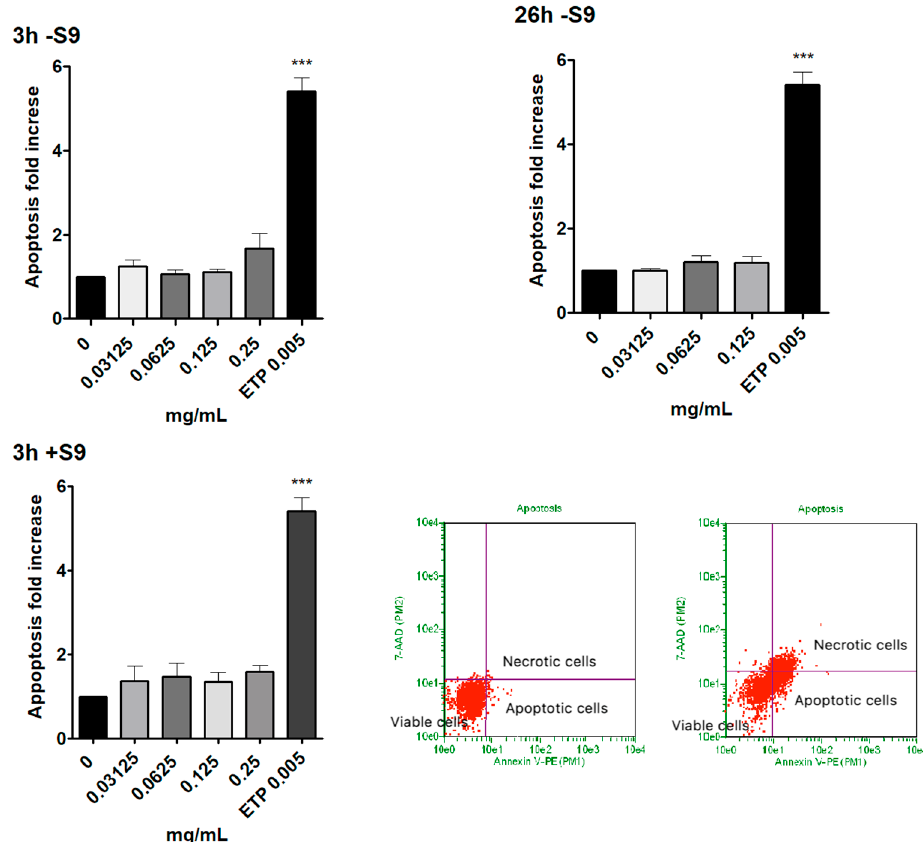
Figure 2. Apoptosis fold increase on TK6 cells after 3 h − S9 mix, 26 h − S9 mix and 3 h +S9 mix treatment with the SMD or ETP at the indicated concentrations compared to the concurrent negative control (0 mg/mL). Each bar represents the mean ± SEM of at least three independent experiments. Data were analysed using repeated ANOVA, followed by Dunnet post-test. *** p < 0.001 vs. (0 mg/mL). Lower right: representative FCM dot plots of viable, apoptotic and necrotic cells after 26 h − S9 mix in culture treated with ETP 5 µ g/mL (right dot plot) and in the concurrent negative control culture (left dot plot).